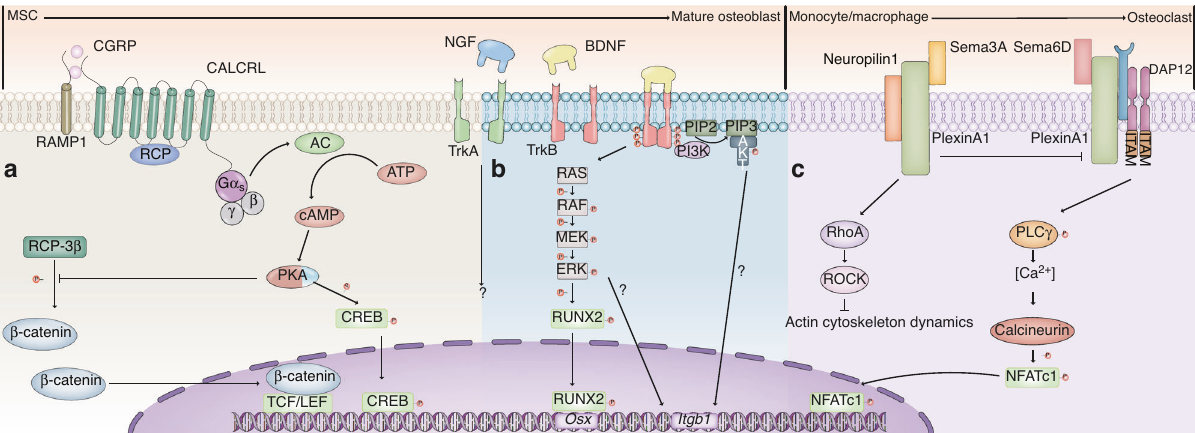
Fig. 5 The diagram shows the possible signaling pathways of three representative neuropeptides (CGRP, BDNF, and Sema3A) that regulate bone formation. a Calcitonin gene ‐ related peptide (CGRP) is the main neuropeptide secreted by sensory nerves whose receptor is a G ‐ protein coupled receptor (GPCR). CGRP binds to the RAMP1-CALCRL complex and activates coupled G α s subunits, which elevates the intracellular cAMP concentration and subsequently activates PKA. PKA inhibits the phosphorylation of β -catenin by GSK-3 β . Unphosphorylated β -catenin translocates into the nucleus, where it associates with TCF/LEF transcription factors. Meanwhile, PKA activates CREB, which translocates into the nucleus and forms a homodimer or heterodimer that binds to the target gene. b Brain-derived neurotrophic factor (BDNF) is an important member of the neurotrophin family. BDNF binding to TrkB leads to the autophosphorylation of TrkB, which activates the PI3K/AKT and MEK/ ERK pathways. RUNX2 is activated by the latter signaling pathway and upregulates the downstream molecule osterix to promote bone formation. The activation of ERK or AKT may contribute to the increased expression of integrin- β 1, which is associated with migration. c Sema3A inhibits osteoclastogenesis in macrophages. Semaphorin 3A (Sema3A) is a secreted protein in the axon guidance protein